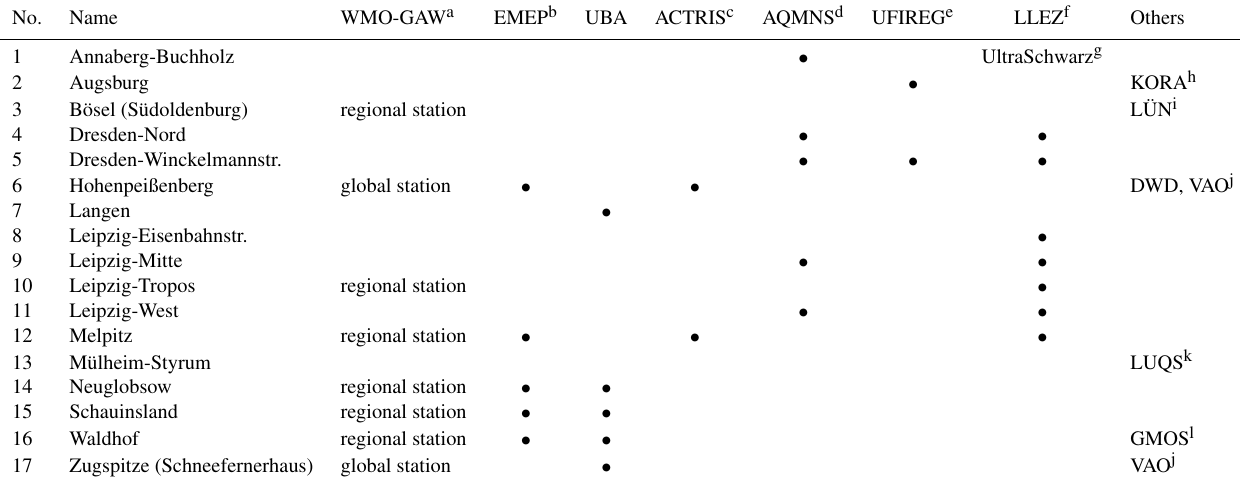
Table 4. Associations of GUAN stations with other air quality networks, infrastructure, and research projects. For further abbreviations, see Table 5.